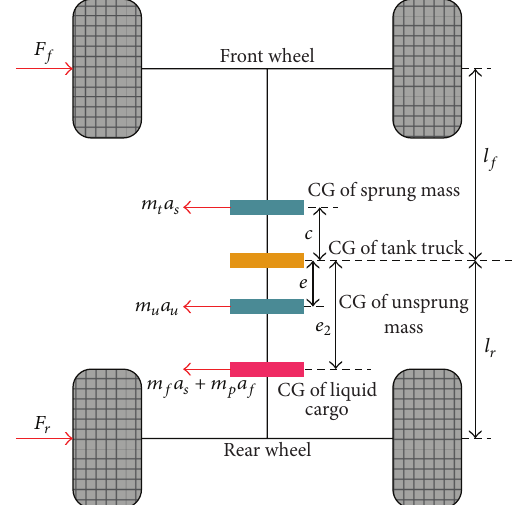
Figure 6: The schematic diagram for the pendulum rotating around the roll